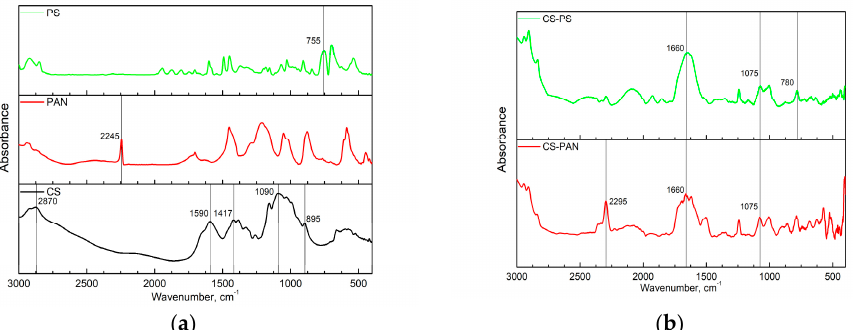
Figure 1. The FTIR spectra of: ( a ) the initial CS, PAN and PS homopolymers, ( b ) CS-PAN and CS-PS copolymers.